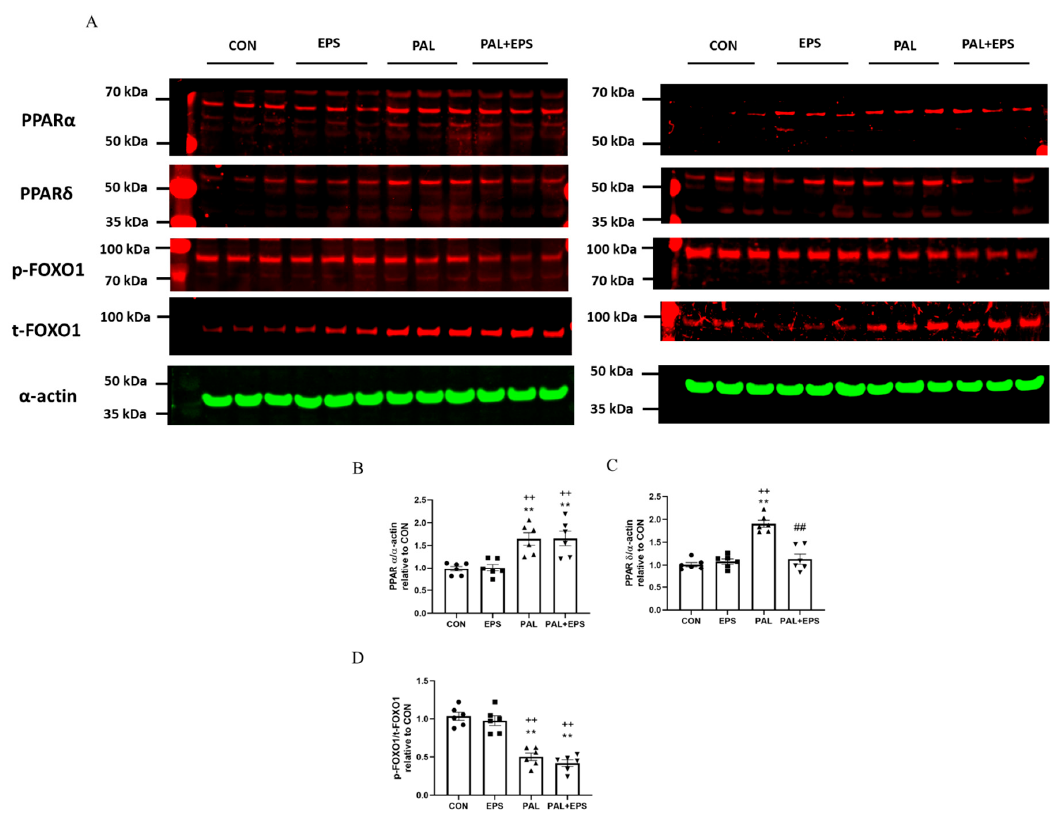
Figure 6. Western blots depicting PPAR α , PPA δ , phosphorylated ( p )-FOXO1, total (t)-FOXO1 and α -actin protein bands with their corresponding molecular weights ( A ), mean band intensities normalised to α -actin for peroxisome proliferator-activated receptor alpha (PPAR α ) ( B ), peroxisome proliferator-activated receptor delta (PPAR δ ) ( C ), and p / t-FOXO1 ( D ) protein expression in C2C12 myotubes whole cell lysates after myotube exposure to either standard growth media (CON), 16 h of electrical pulse stimulation (EPS; 11.5 V, 1 Hz, 2 ms), 300 µ M palmitate (PAL) or the combination of both interventions (PAL + EPS). Significantly di ff erent from control (CON; ** p < 0.01). Significantly di ff erent from palmitate (PAL; ## p < 0.01). Significantly di ff erent from EPS ( ++ p < 0.01). Data represent mean ± SEM of 6 individual experiments in each study group.